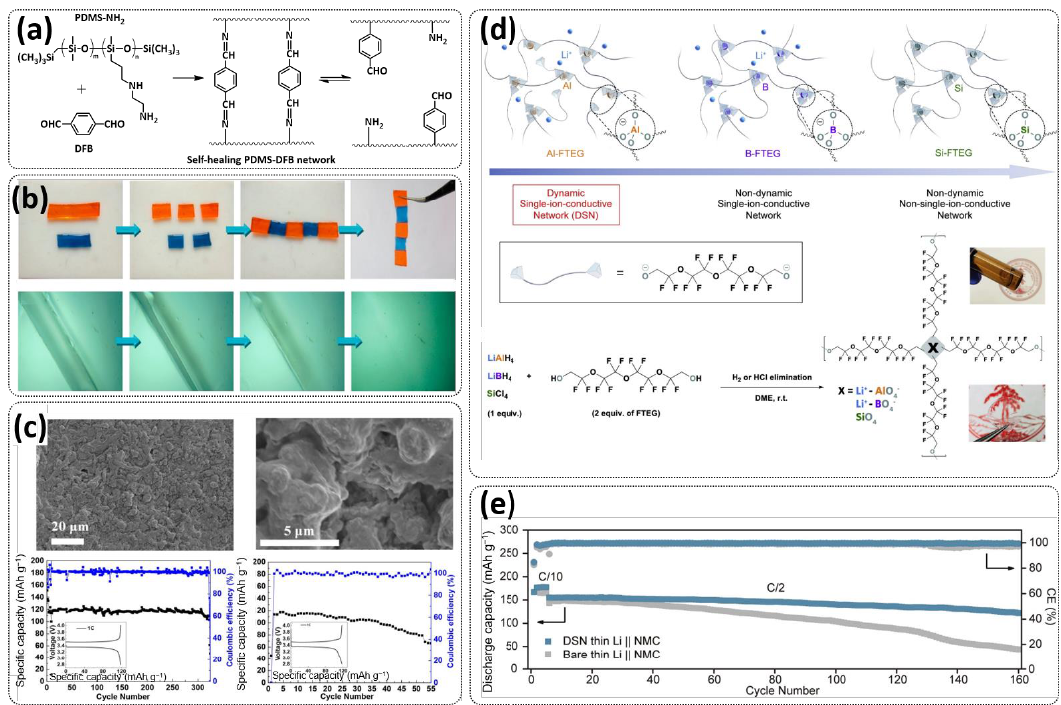
Figure 19. ( a ) Synthesis of a self-healing PDMS-DFB network. ( b ) Optical and optical microscopic images of the self-healing of the PDMS-DFB elastomer under ambient conditions (25 °C). ( c ) ( above ) SEM images of the Li deposits on Cu-PDMS electrodes after 50 cycles of deposition/stripping with 1 mAh cm – 2 at 0.5 mA cm – 2 . ( below ) Cycling performance of Li/LiFePO 4 full cells comprising the PDMS-DFB-coated Li-metal anode ( left ) and bare Li-metal anode ( right ). The anode was predeposited on 5 mAh cm – 2 Li-metal and tested at 0.2C for the first cycle and 1.0C for the later cycles. The insets are the charge – discharge profiles of the corresponding cells. Reproduced with permission from [153]. Copyright © 2018, American Chemical Society. ( d ) Material design and chemical structures of the DSN and derivatives. ( e ) Long-term cycling performance of the DSN thin Li||NMC532 (cyan) and bare thin Li||NMC532 (gray) full batteries. Reproduced with permission from [154]. Copyright © 2019 Published by Elsevier Inc.